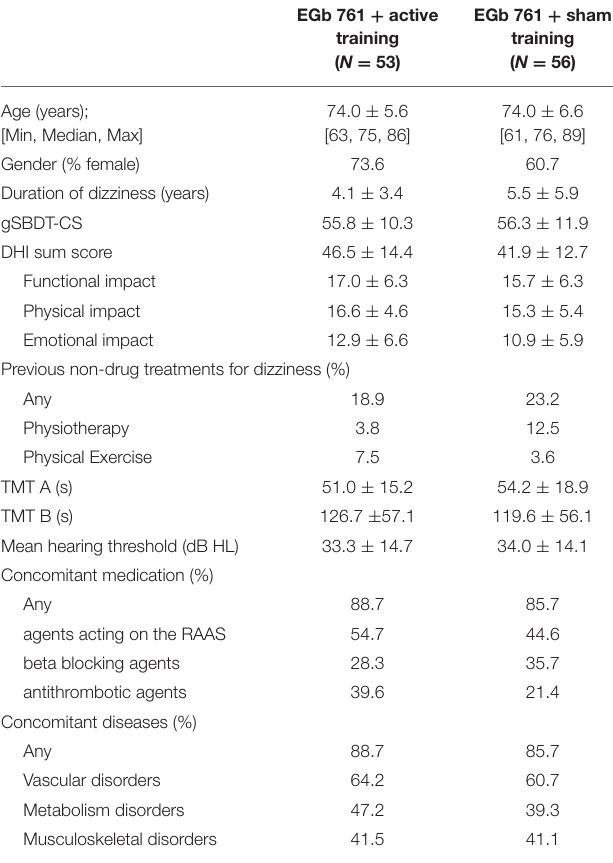
TABLE 1 | Patient